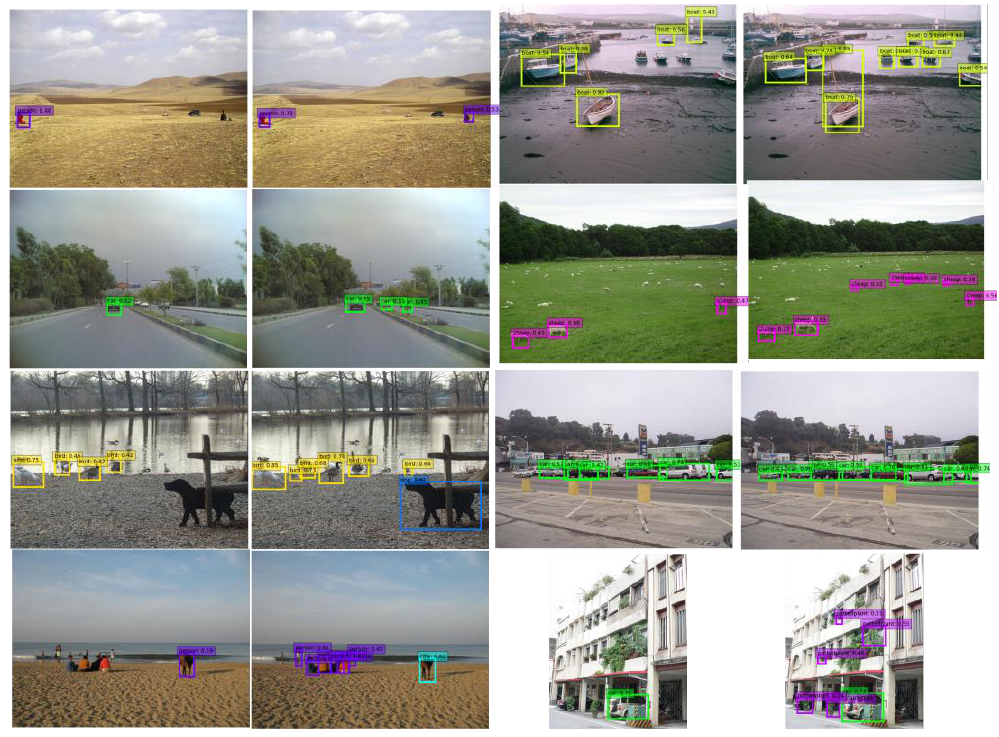
Figure 6. Comparisons of small object detection results between the classical YOLOv2 method (the first and third columns) and the Multi-view YOLOv2 method (the second and fourth columns).